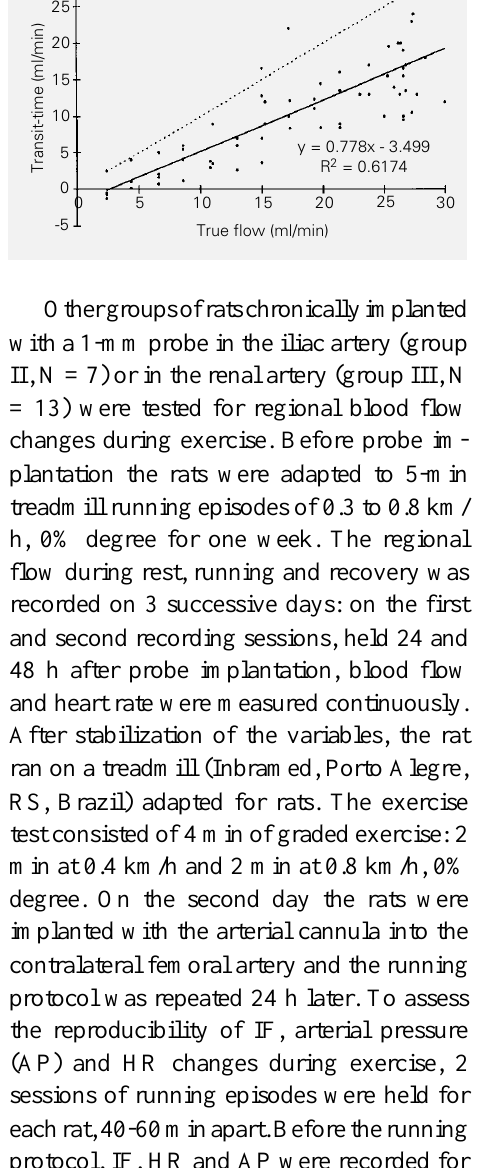
Figure 1 - In vitro calibration of 1-mm (upper panel) and 2-mm (lower panel) probes implanted around the rat common carotid artery. Symbols represent ex- perimental data obtained with 1- mm (N = 4) and 2-mm (N = 2) probes. The solid line represents the slope of the data and the dotted line, the line of identity. Parameters of linear regression analysis are